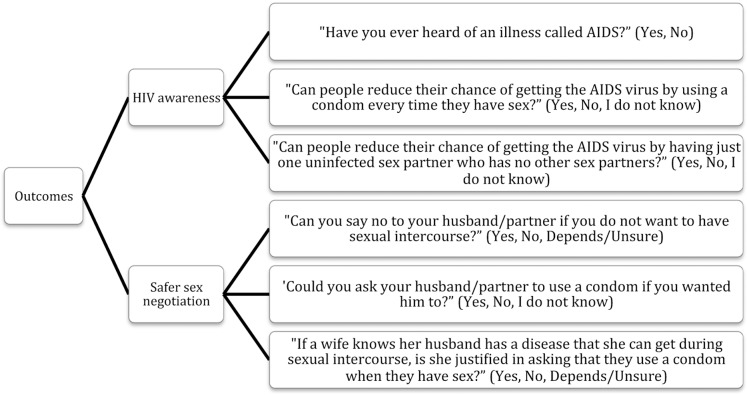
Selected indicators.